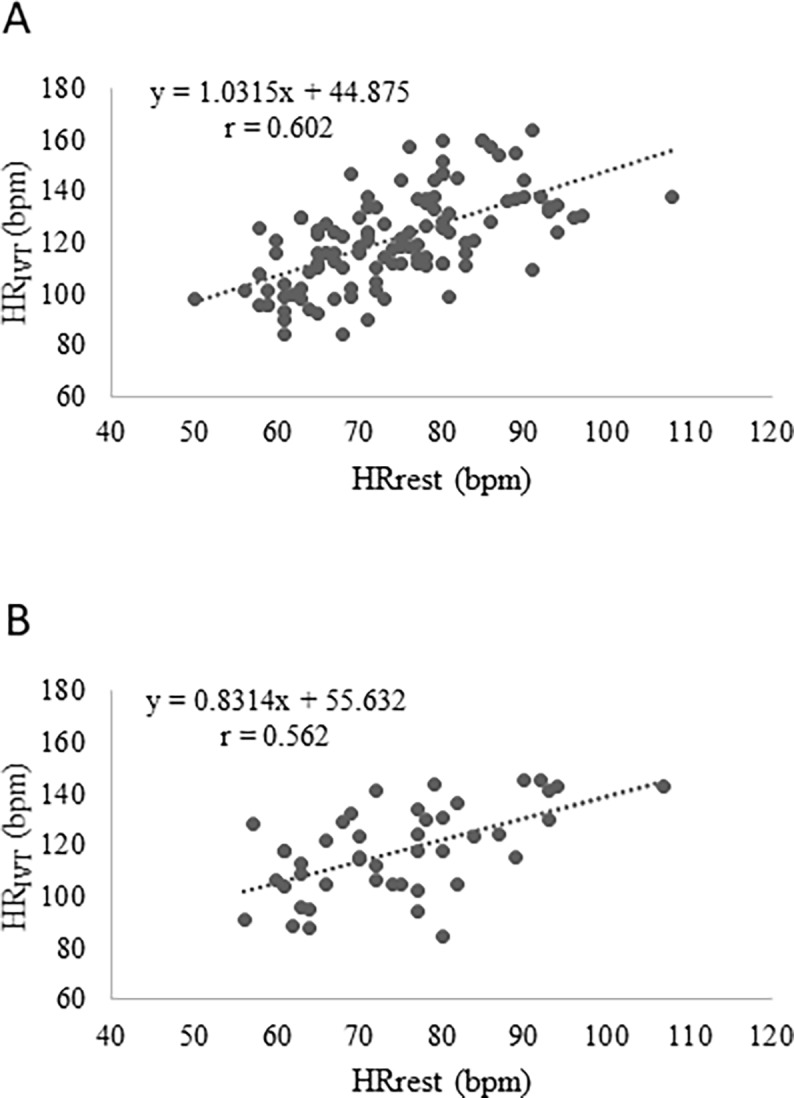
Scatterplot of HR at IVT (HRIVT) to resting HR (HRrest) for females (A) and males (B).